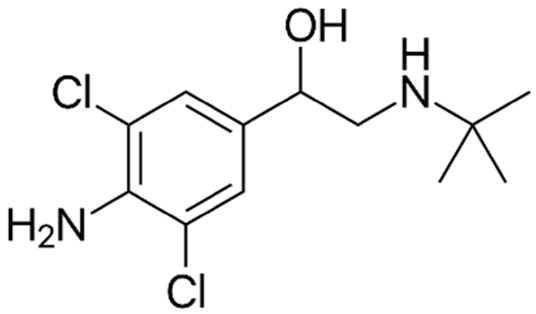
Figure 1. Structure of clenbuterol (1-(4-Amino-3,5-dichlorophenyl)-2-tert-butylaminoethanol).